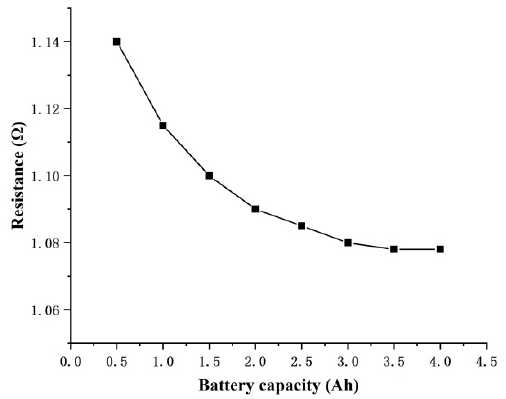
Figure 7. Internal resistance test results of the ZnBr 2 flow cell.